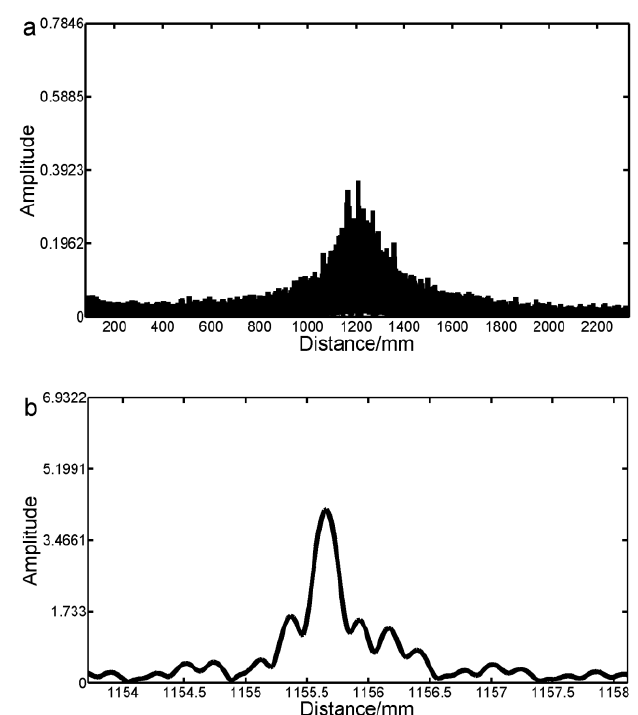
Figure 7. Part ( a , b ) respectively represent the experiment results of not using andusing the adaptive filtering method and the mosaic algorithm with the same filtering method and the mosaic algorithm with the same data.